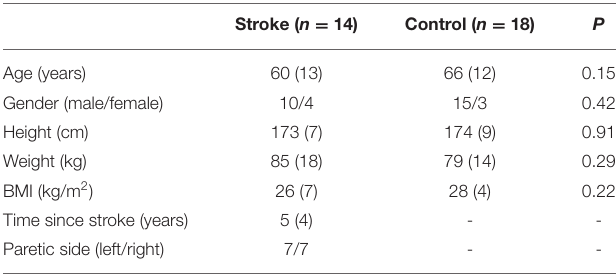
TABLE 1 | Participant characteristics.